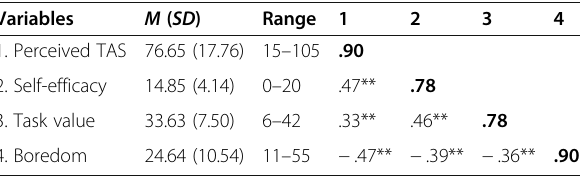
Table 1 Descriptive statistics, Cronbach alpha and correlation matrix for the study variables